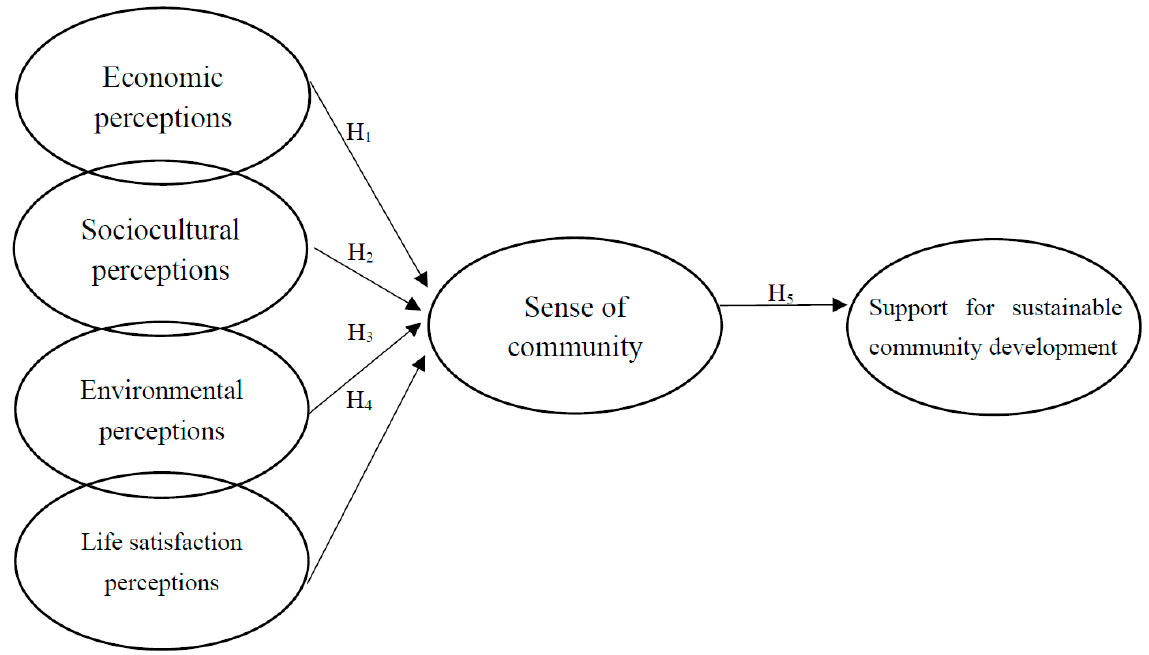
Figure 1. Theoretical model.